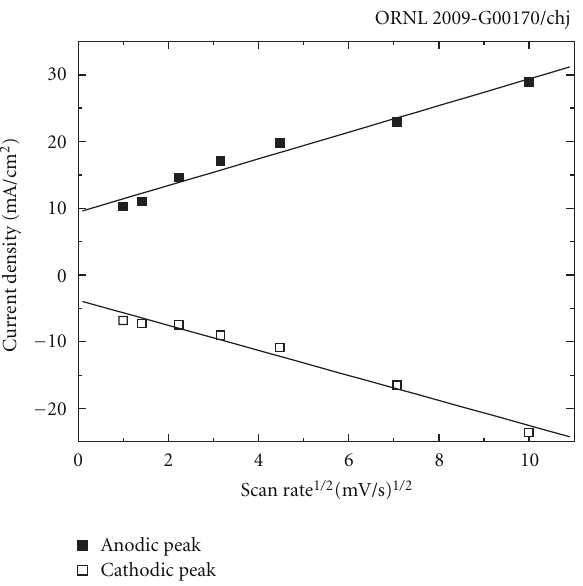
Figure 6: Anodic and cathodic peak current densities from Figure 5(a) as a function of the square root of the scan rate. The lines show a least squares fit to the data with an R 2 = 0 . 98.